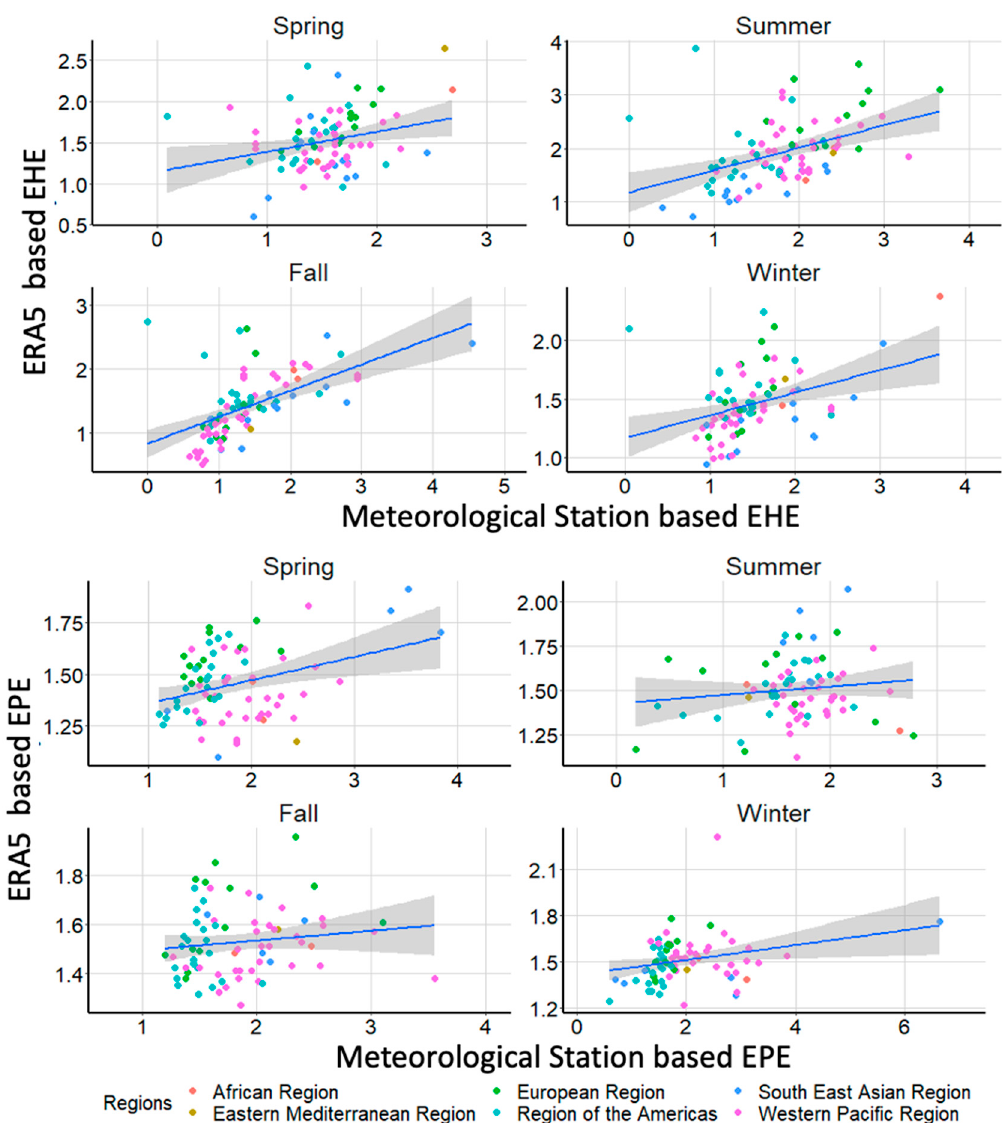
Figure 5. Correlation between weather station vs. ERA5 based EHE ( A ) top and EPE ( B ) bottom frequencies during 1980–2017.